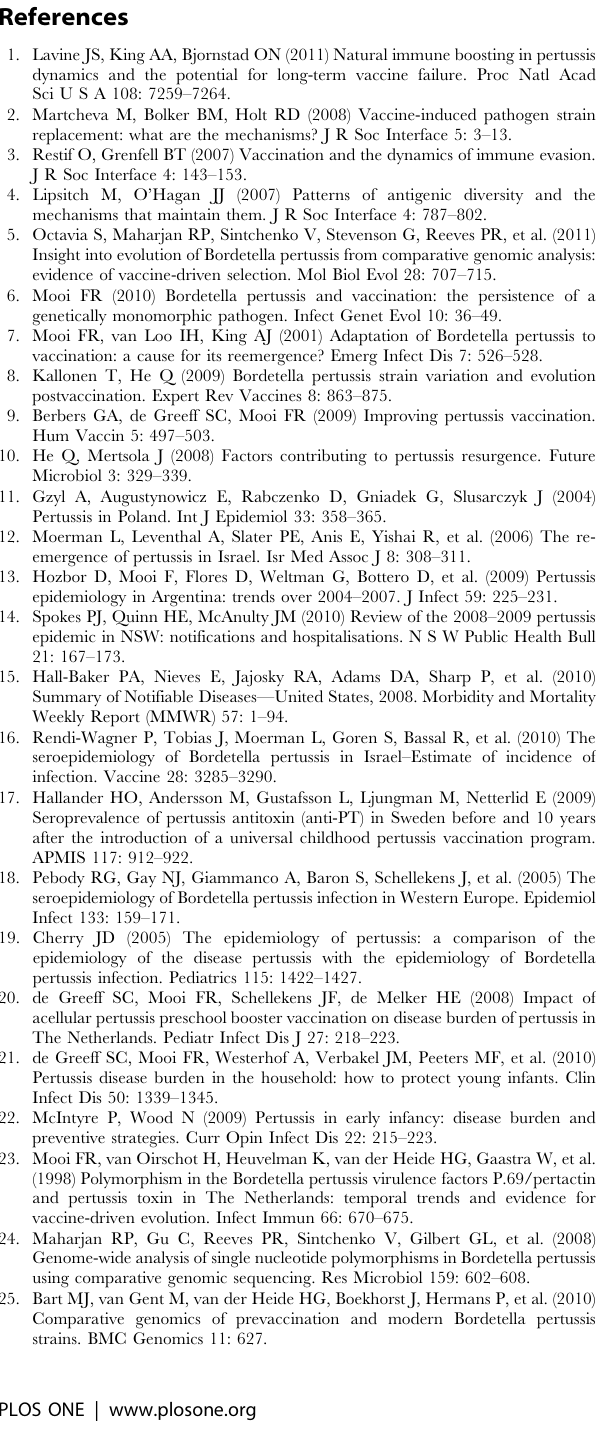
position in Tohama I are indicated. Abbreviation: SNP, single nucleotide polymorphism. Table S3 List of all deleted genes. RD number, locus, name and gene product are indicated. Table S4 SNPs linked to the alleles ptxA1 , prn2/3 , ptxP3 and fim3-2 . SNPs were identified by comparing the genome sequences of 11 B. pertussis clinical isolates and the Tohama I strain [46] [25] and this work]. The degree of linkages was further assessed using a larger number of strains (N 45). Strains were